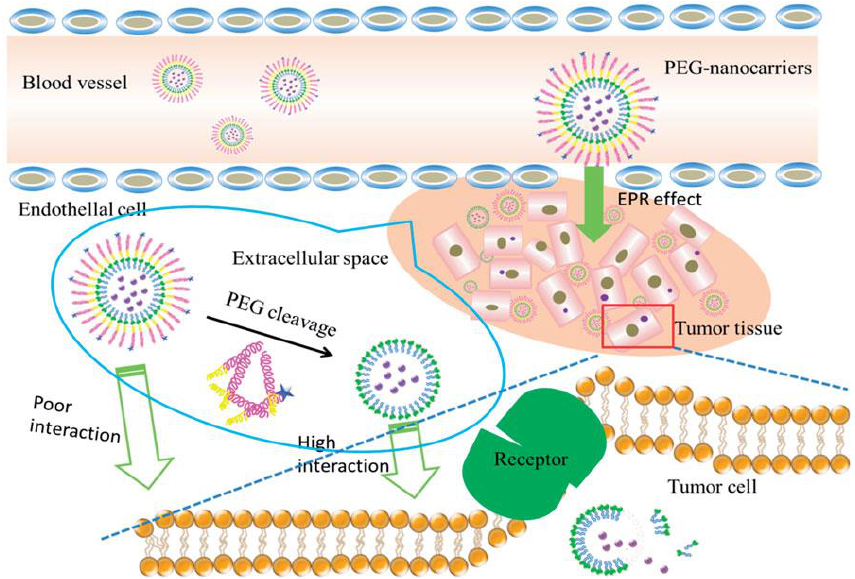
Figure 14. Principal mechanics of pH-sensitive PEG-shedding carriers. In the bloodstream, they utilize the stealth effect, then they accumulate in the tumor region due to the EPR effect, where a mildly acidic pH is responsible for PEG cleavage and enhanced absorption of the unpegylated